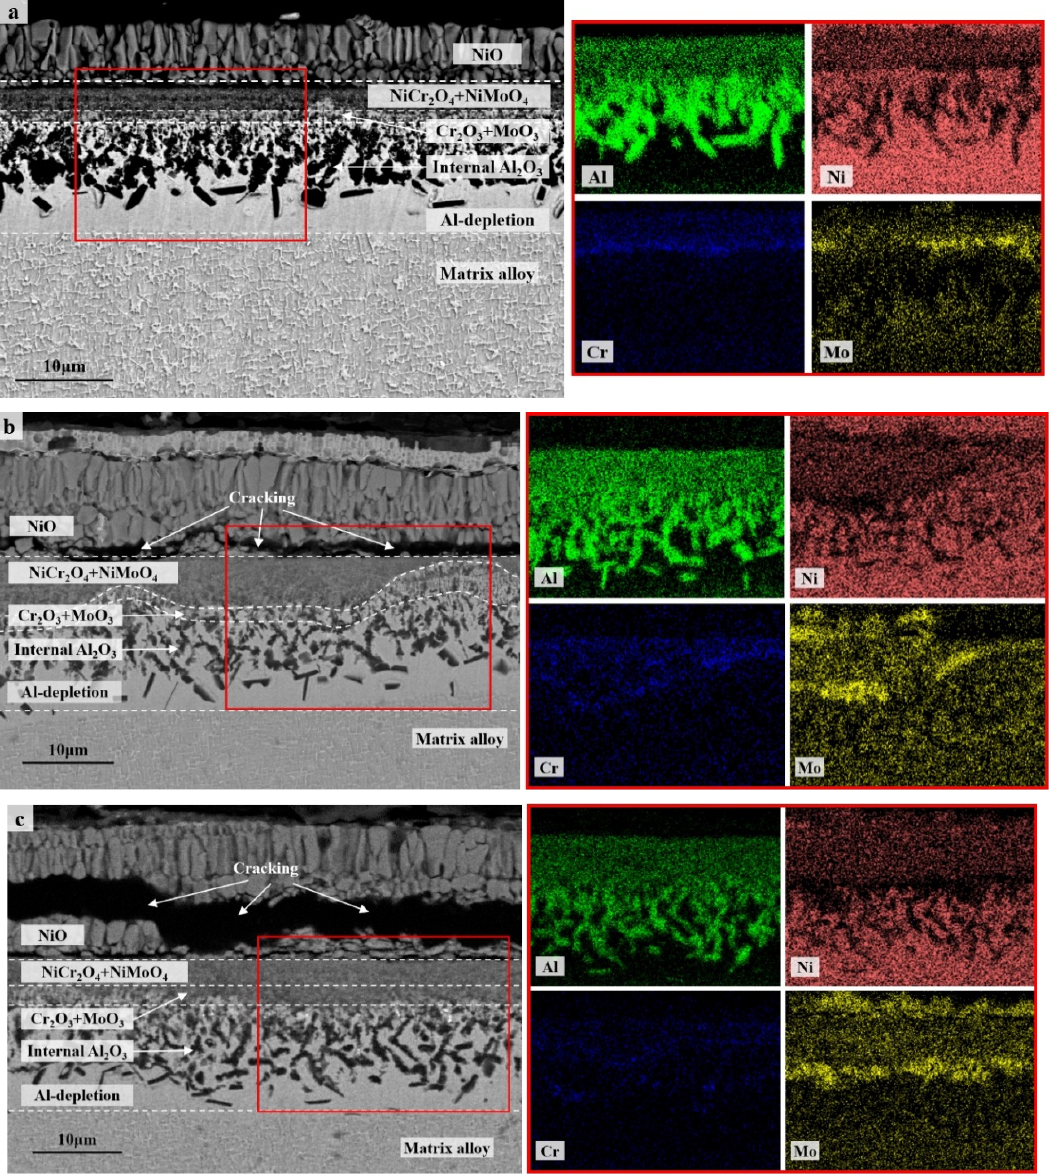
Figure 4. Cross-section morphologies (BSE) and composition distributions (EDS map scanning) of the oxide scales on the specimens of IC21 alloy with different thicknesses after 100 h of cyclic oxidation at 900 ◦ C: ( a ) S01-N, 0.1 mm; ( b ) S03-N, 0.3 mm; ( c ) S10-N, 1.0 mm. The red square is the area of EDS map scanning.